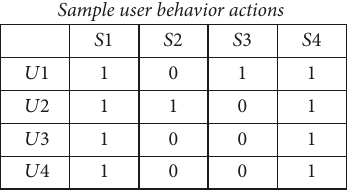
Figure 7: User-item matrix.